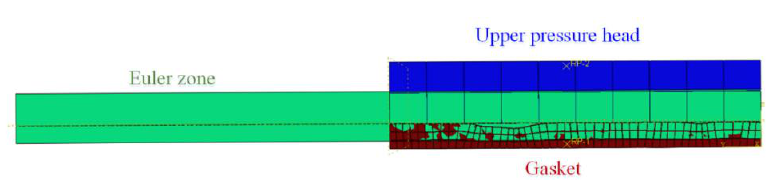
Figure 6. Schematic diagram of boundary conditions. Table 2. Physical parameters of nitrogen. Physical Quantities